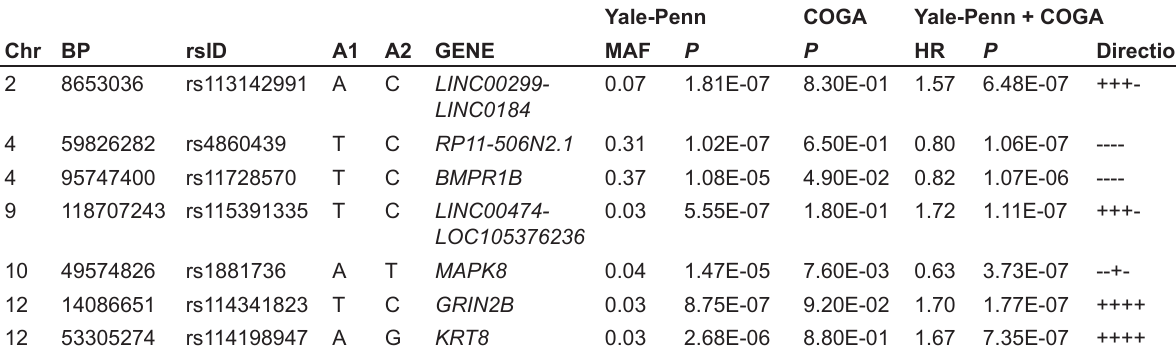
Table 4. Top associations for time to OD in AAs